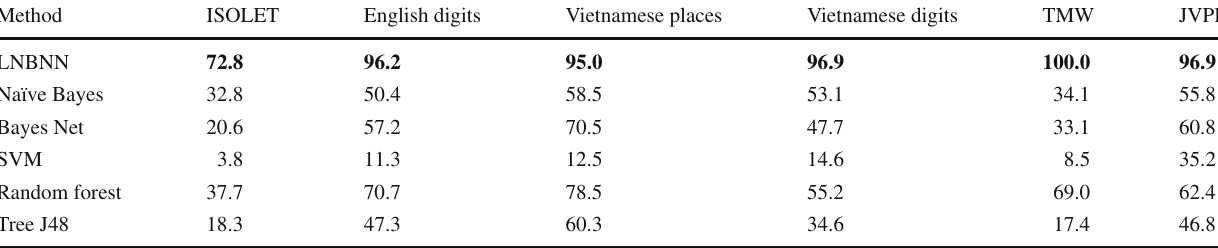
Bold values indicate highest value in the column Table 4 Average correct classification rate on increment update samples training